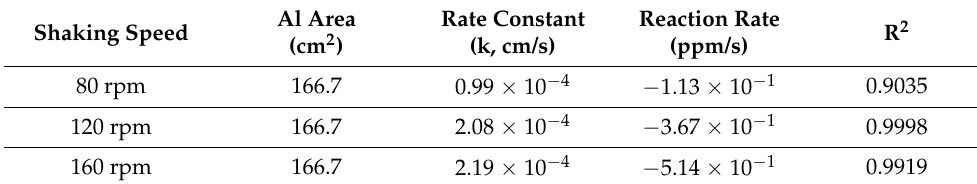
Table 6. Summary of rate constant for the cementation of Au as a function of shaking speed